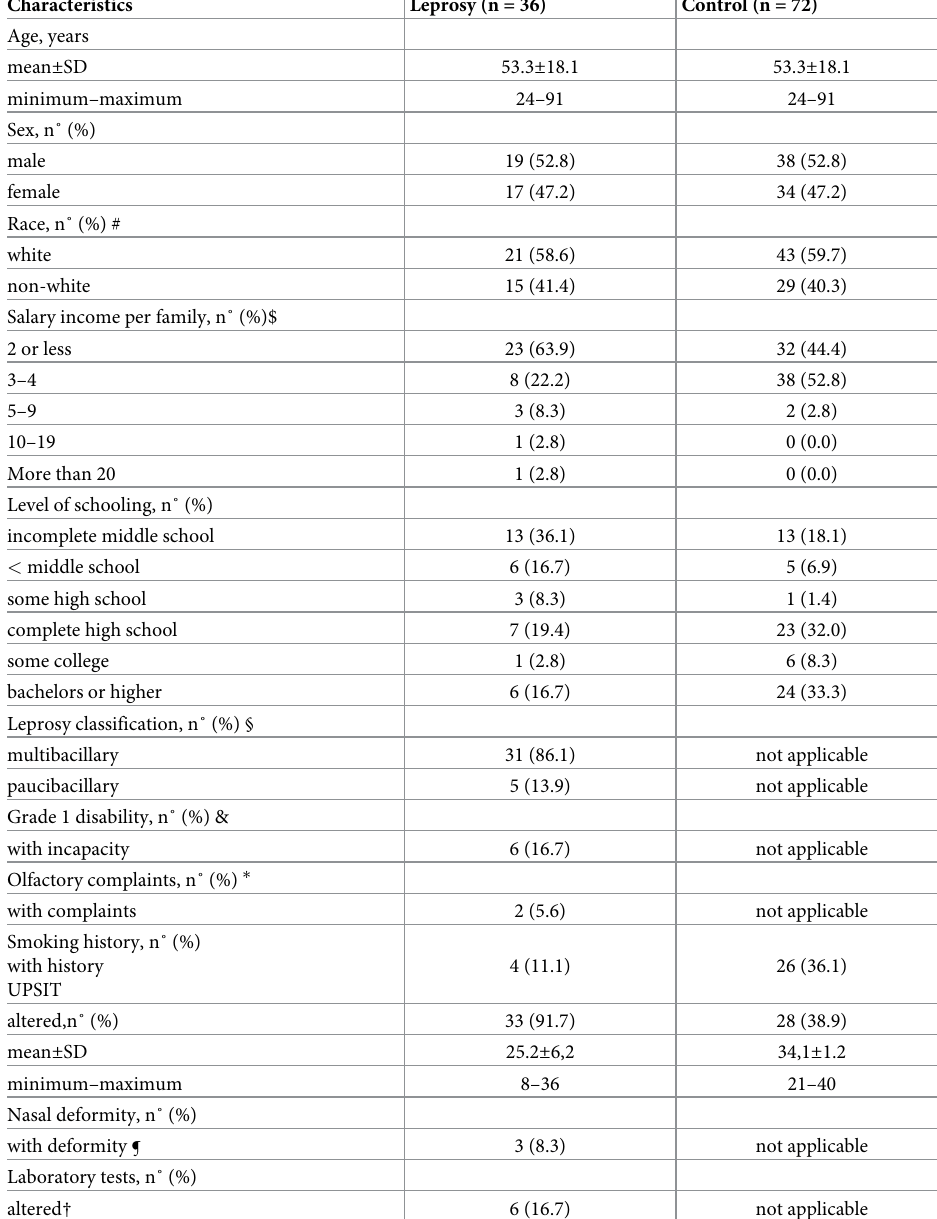
Table 1. Clinical and demographic characteristics (N =